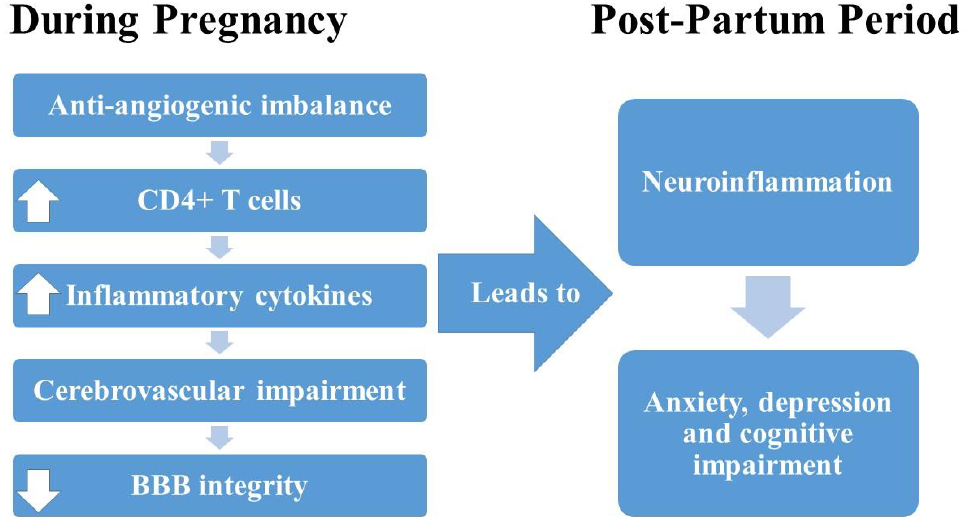
Figure 6. Working hypothesis outlining the relationship between anti-angiogenic imbalance during pregnancy and post-partum changes in mood and cognitive impairment. In summary, the connection between HDP and mood disorders is still somewhat unclear; however, inflammation has been proposed to play a large role. Conversely, the connection between HDP and inflammation and brain damage are somewhat more defined. The combination of this study and clinical studies point to significant changes in